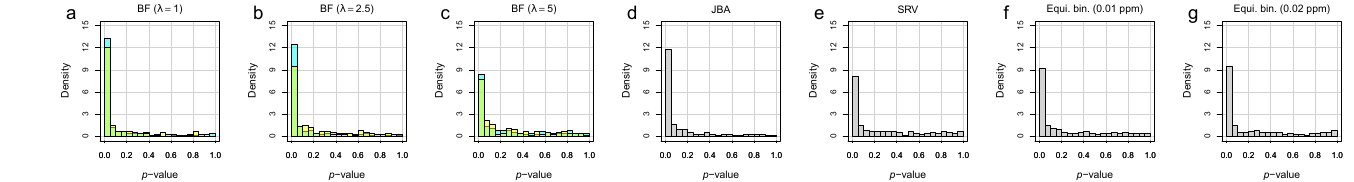
Figure 2. The p -value distributions of AKI versus non-AKI patients after cardiac surgery in urine specimens: ( a – g ) the different binning approaches (BF with λ = 1, BF with λ = 2.5, BF with λ = 5, JBA, SRV, equidistant binning with a bin size of 0.01 ppm, and equidistant binning with a bin size of 0.02 ppm, respectively). For the BF method, the same color-coding was applied as that in Figure 1, for example. Note that the light green bars correspond to the overlapping regions of the cyan and yellow bars.